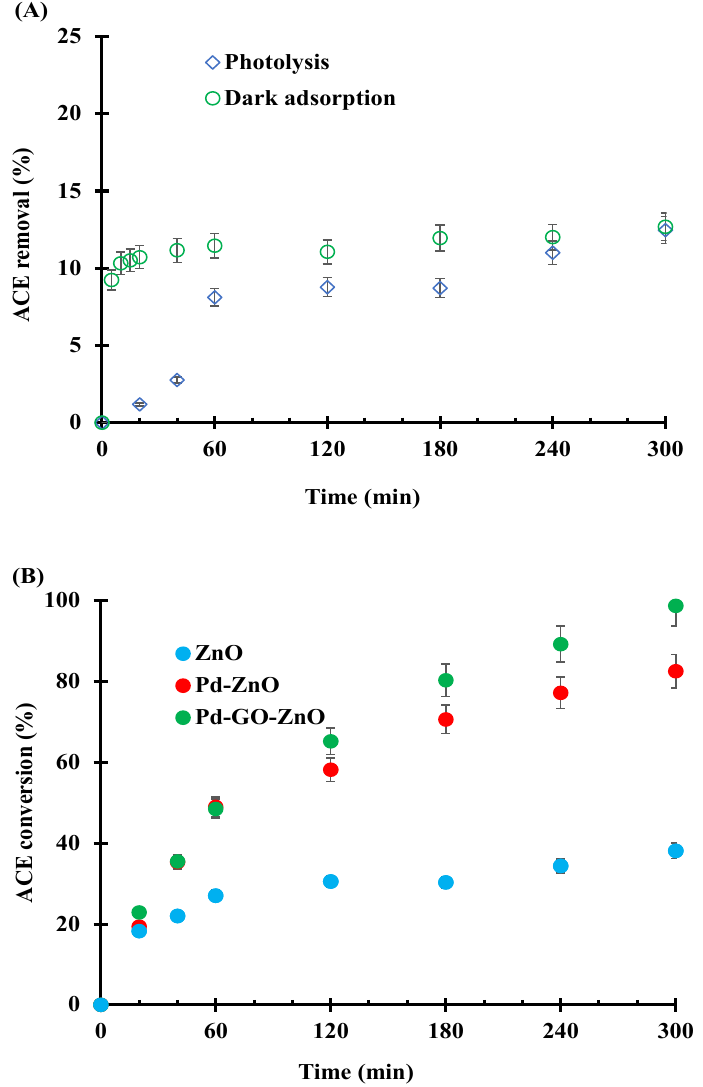
Figure 8. Acetamiprid photolysis and dark adsorption time profiles ( A ) and acetamiprid photocatalytic degradation time profiles ( B ). Catalyst loading = 0.2 g/L; Temperature = 25 °C; C 0 = 15 mg/L; Error bars indicate standard deviation.